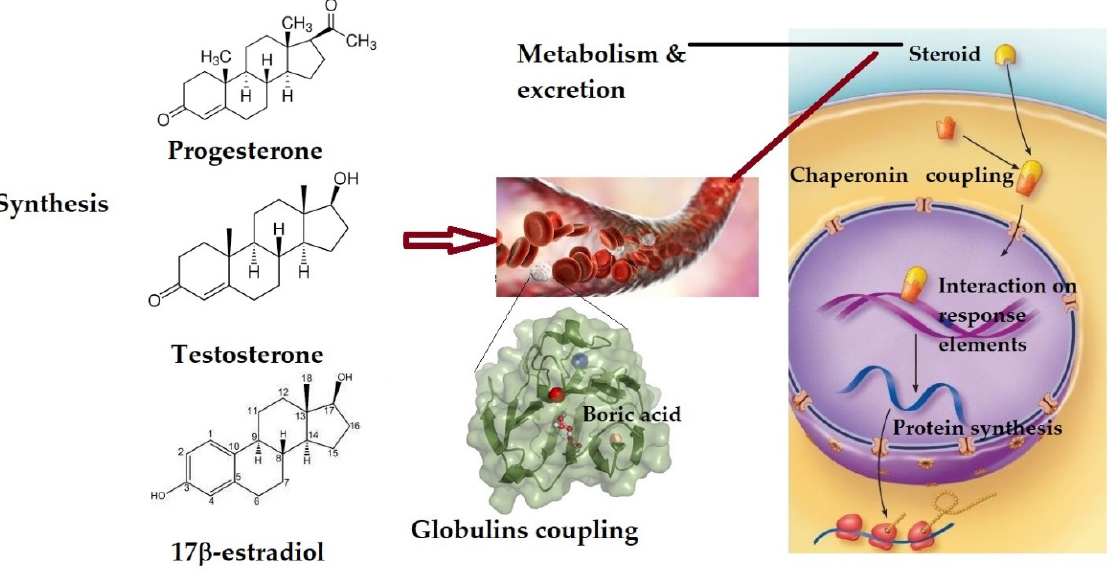
Figure 1. The potential effects of BCC in steroid–hormone synthesis, pharmacokinetics, and pharma- codynamics linked to the observation of changes in plasma concentration after B supplementa- tion.